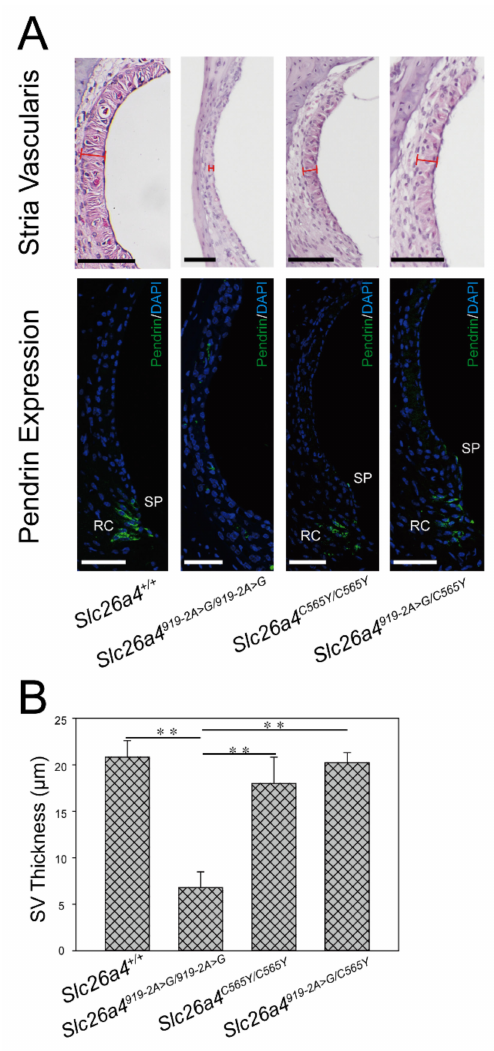
Figure 4. Morphology of stria vascularis (SV) and pendrin expression. ( A ) Histology and ex- pression of pendrin in stria vascularis. Significant atrophy of SV and poor protein expression of pendrin were observed in Slc26a4 919-2A>G/919-2A>G mice. By contrast, pendrin was normally distributed in spiral prominence (SP) and root cells (RC) in Slc26a4 +/+ , Slc26a4C 565Y/C565Y , and Slc26a4 919-2A>G/C565Y mice, similar to in that of wild-type mice. Tissue samples harvested from mice at 3 months (bar = 50 µ m). ( B ) Quantification data of SV thickness. SV thickness in each group of mice was calculated ( n = 3). In Slc26a4 +/+ , Slc26a4 C565Y/C565Y , and Slc26a4 919-2A>G/C565Y mice, SV was thicker than that of Slc26a4 919-2A>G/919-2A>G mice, in which SV was atrophic (** p <